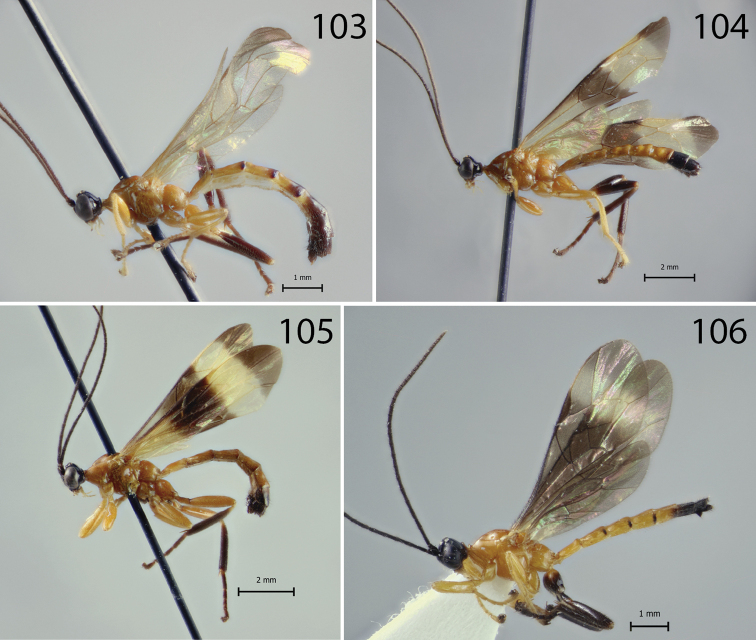
Habitus of Hymenoepimecis spp. (males), lateral view 103H.
manauara104H.
rafaelmartinezi sp. nov. (paratype) 105H.
ribeiroi106H.
uberensis.